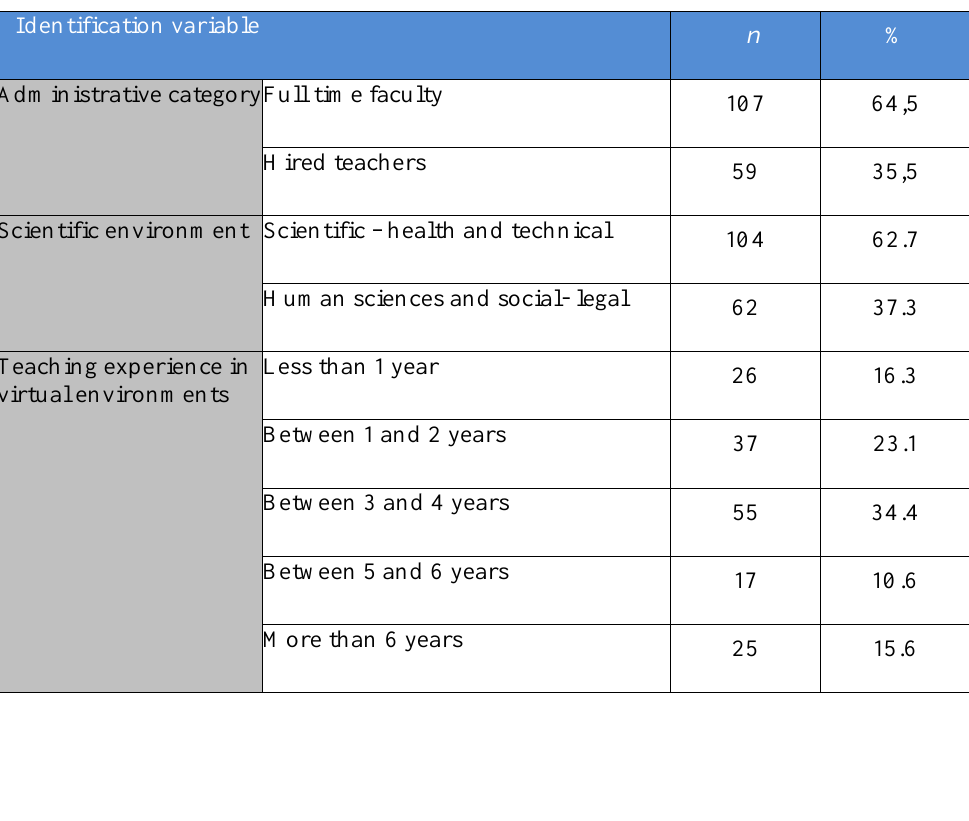
Characteristics of the Sample Population Arranged by the Categories: Administrative, Scientific Environment And Teaching Experience within Virtual Environments Identification